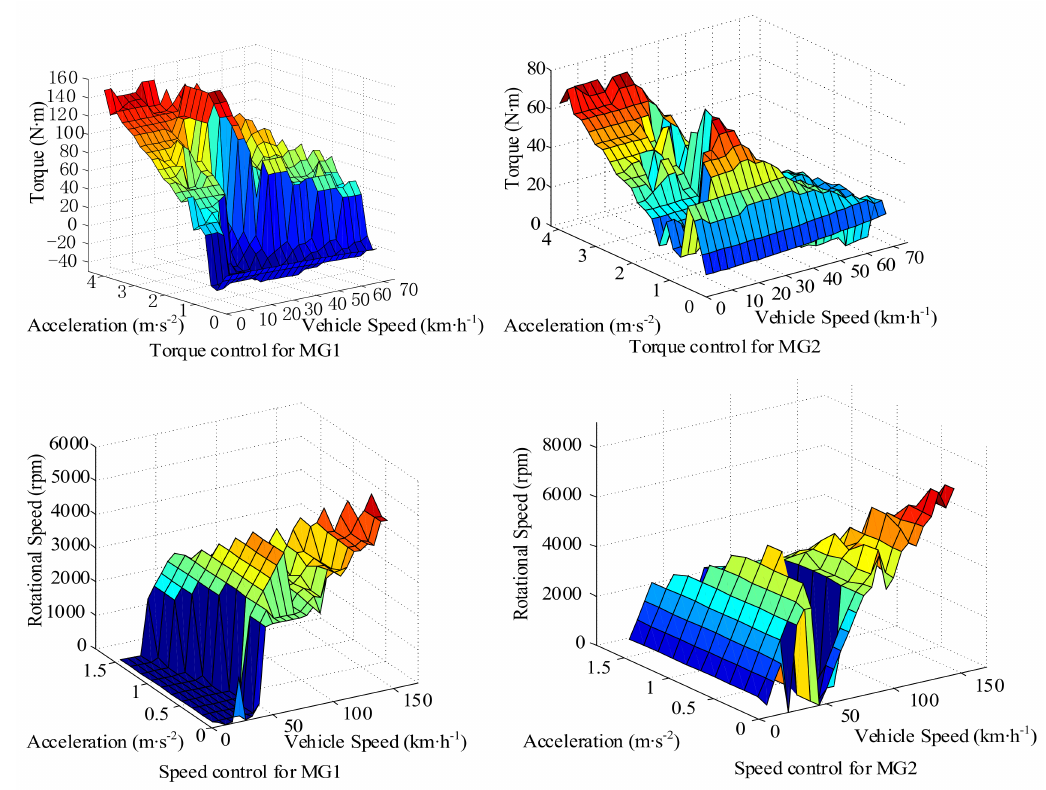
Figure 5. Power distribution strategy for main motor (MG1) and auxiliary motor